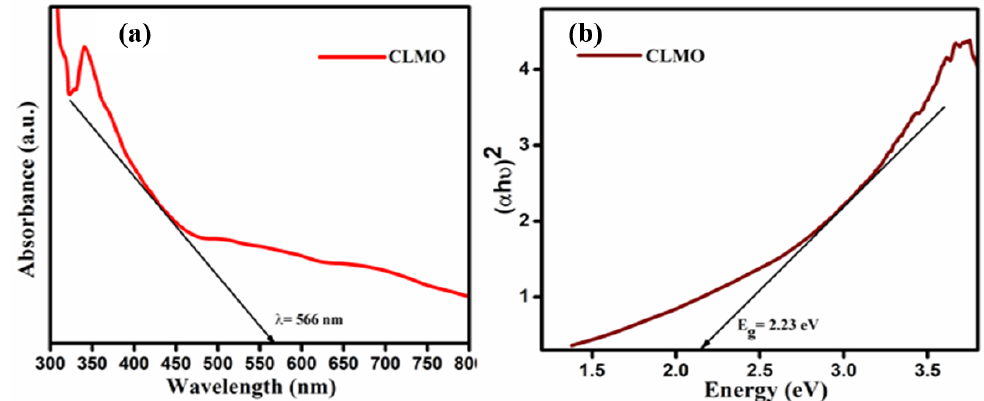
Figure 3. ( a ) UV-Vis diffuse reflectance spectra and ( b ) Tauc plot of as-synthesized CLMO photo- catalyst.